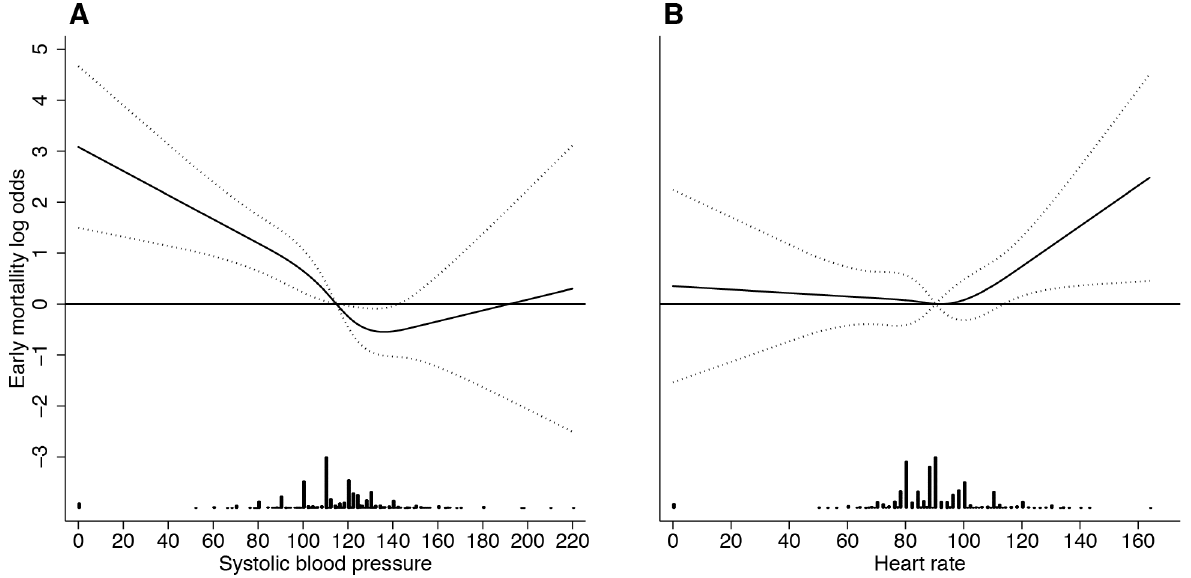
Figure 1. A – B. Nonlinear associations between systolic blood pressure, heart rate, and early mortality modelled using restricted cubic splines. The horizontal solid lines represent log odds=0. The dotplots in the bottom represent density of observed values. A. Adjusted for heart rate and Glasgow coma scale. B. Adjusted fo¨r systolic blood pressure and Glasgow coma scale. doi:10.1371/journal.pone.0105606.g001 PLOS ONE |